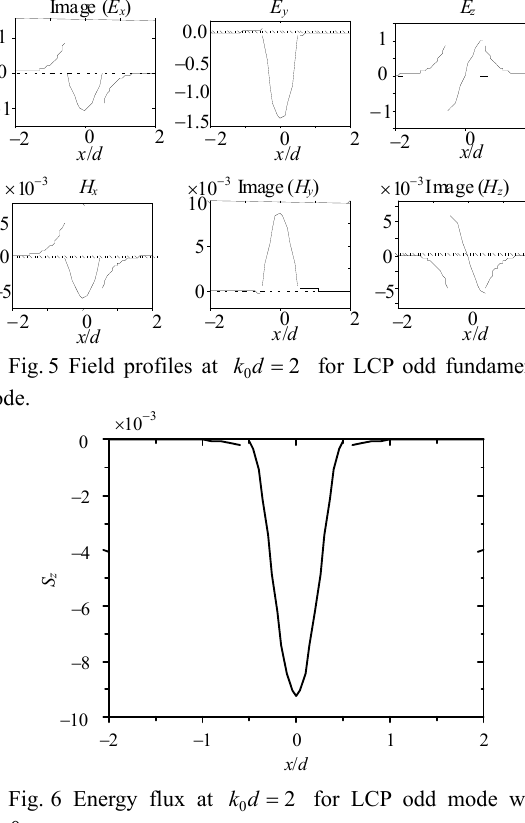
2 k d  for LCP odd mode when 0